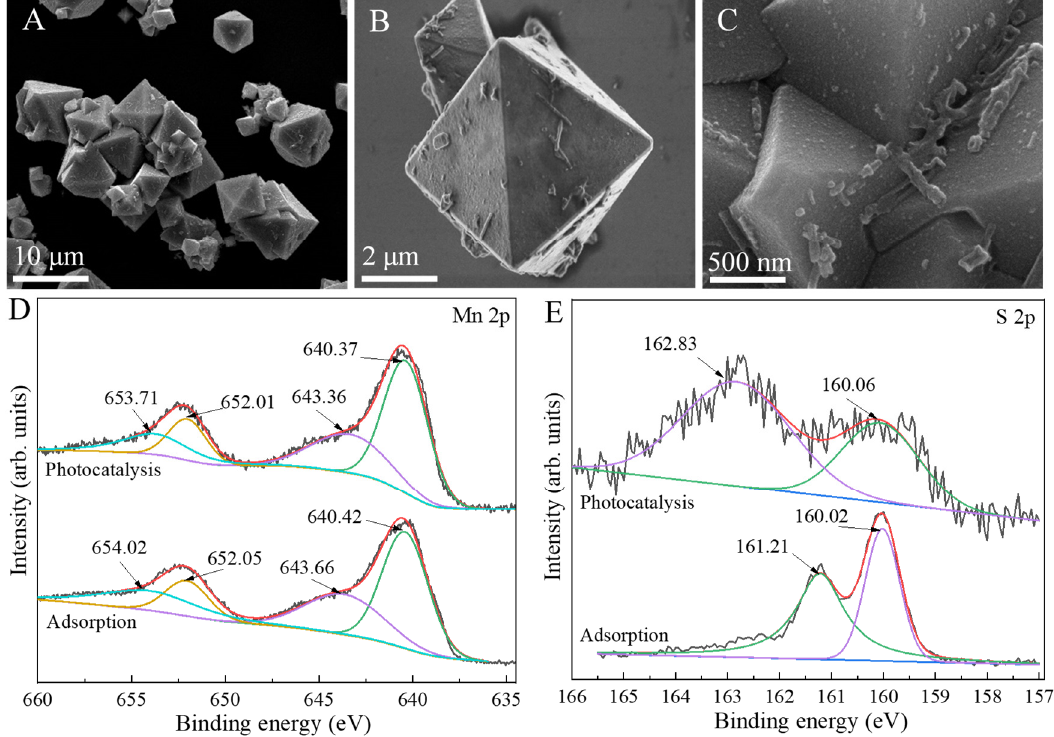
Figure 9. SEM images ( A – C ) and XPS spectra ( D , E ) of used